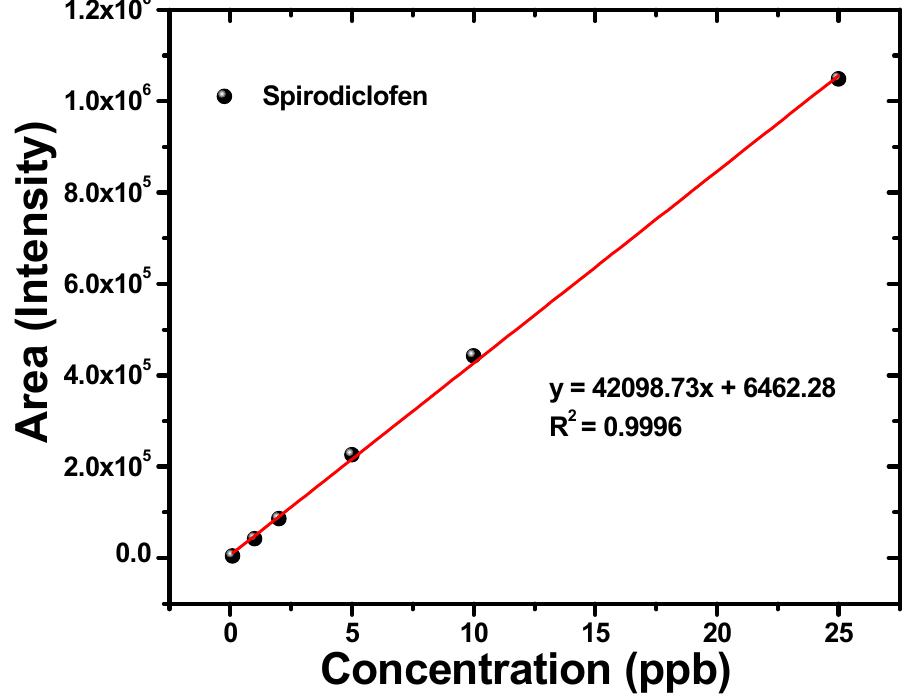
Figure 2. Linear regression curve of Spirodiclofen.